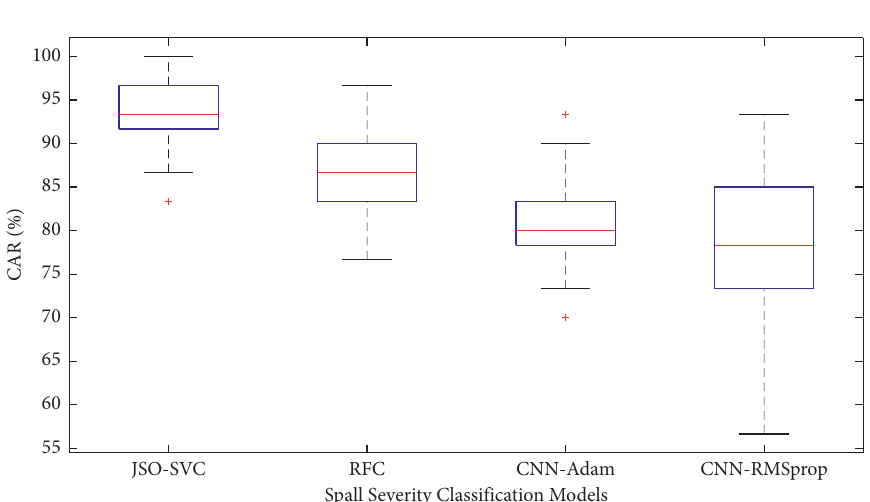
Figure 9: Boxplot of CAR values obtained from the employed machine learning